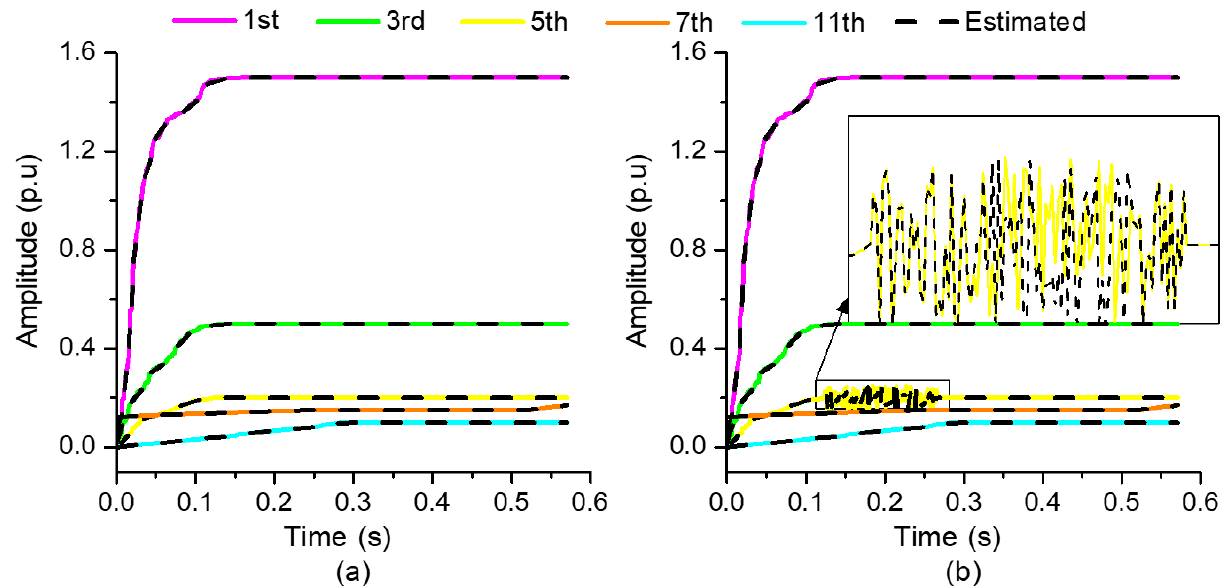
Figure 12. Estimation in harmonics amplitude ( a ) steady state condition ( b ) transient in 5th